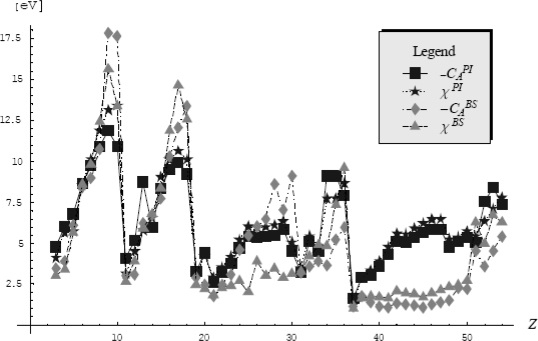
The comparative representation of the atomic electronegativities’ values computed upon Equation (400) and the corresponding absolute chemical actions – given by Equation (5) – using the path integral (PI) and basis set (BS) methods.